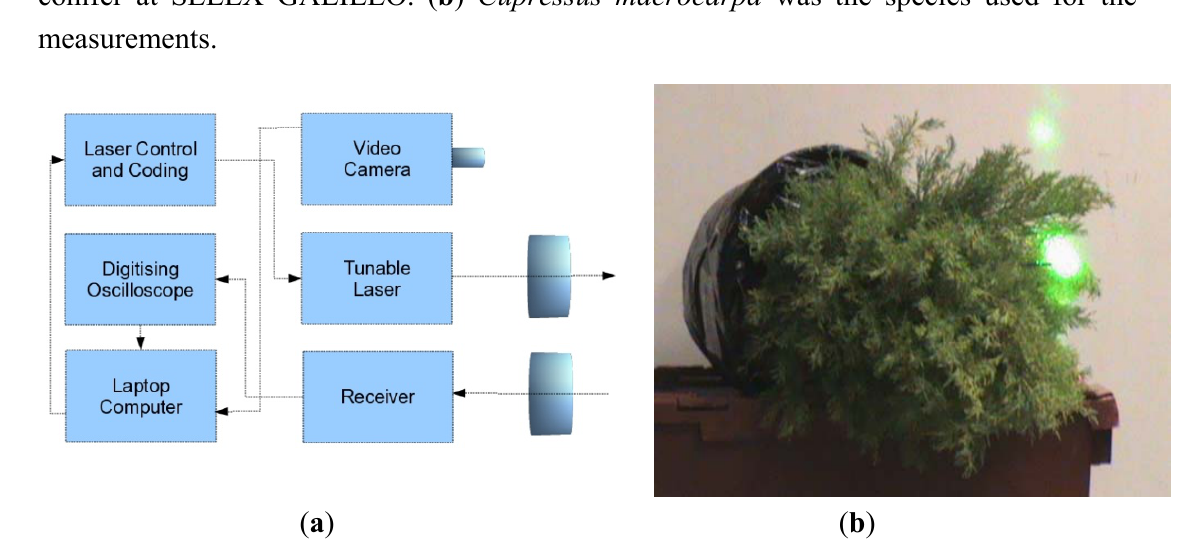
Figure 1. ( a ) Multispectral pulsed laser system built and used for measurement of a small conifer at SELEX GALILEO. ( b ) Cupressus macrocarpa was the species used for